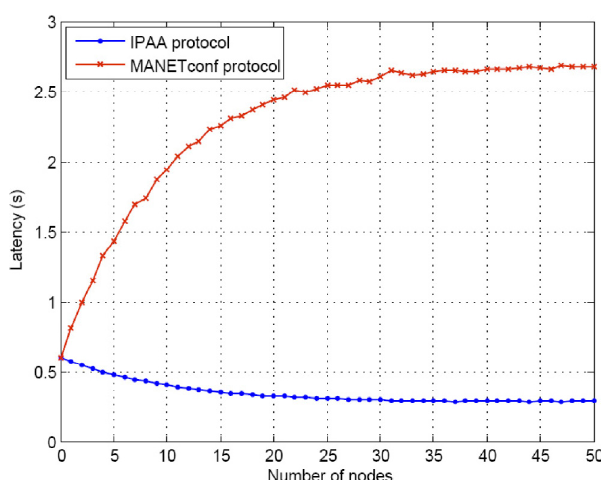
Figure 6. Latency of the IPAA and MANETconf protocols as a function of network